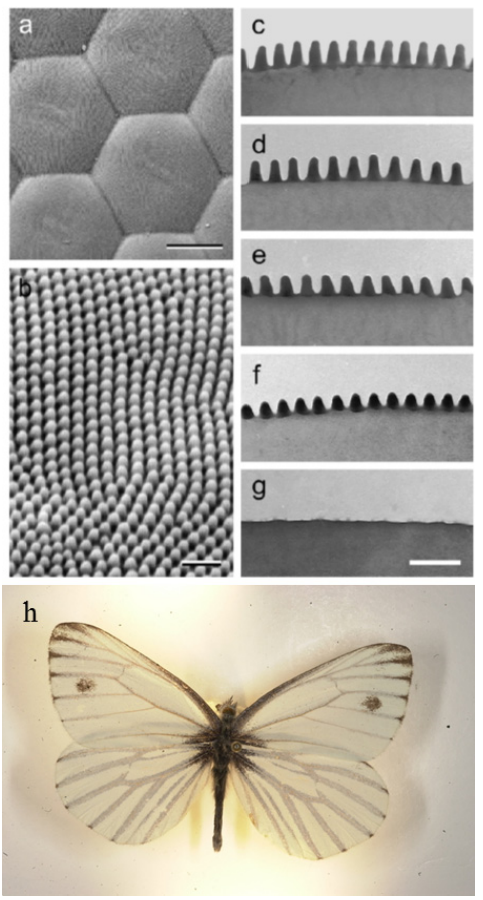
Figure 1. Example images of moth-eye structures found in nature. The scale bars are ( a ) 10 µm; ( b – g ) 500 nm. Example image of Pieris napi ( h ). Figure 1a–g reprinted with permission from reference [4], Copyright 2006 Elsevier; Figure 1h reprinted with permission from reference [5], Copyright 2004–2013 John